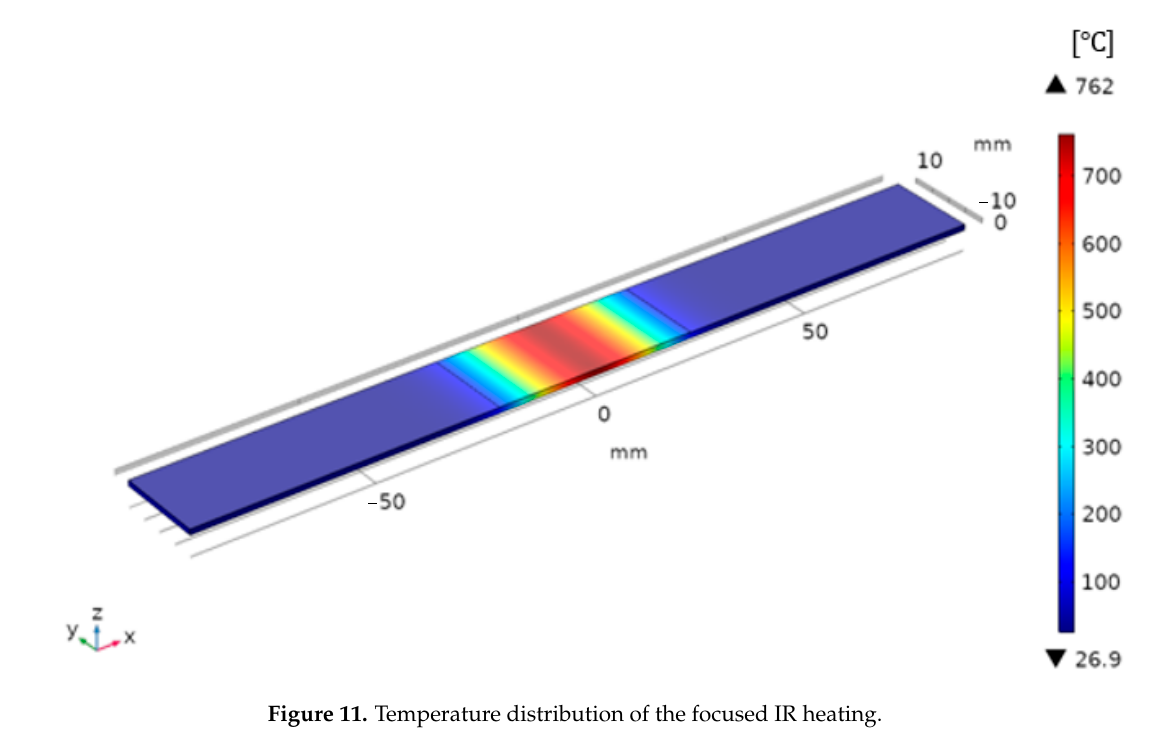
Figure 11. Temperature distribution of the focused IR heating.